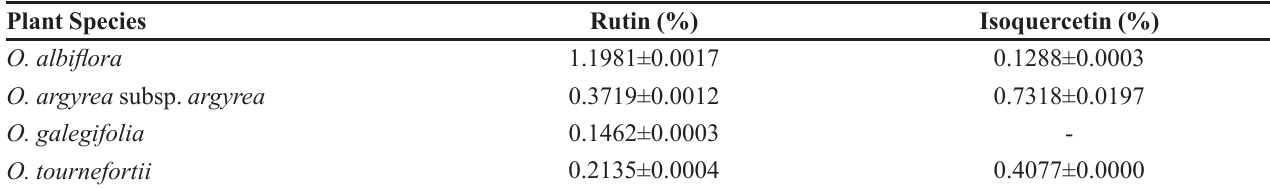
TABLE III - Blood sugar levels of alloxan-induced diabetic mice Groups